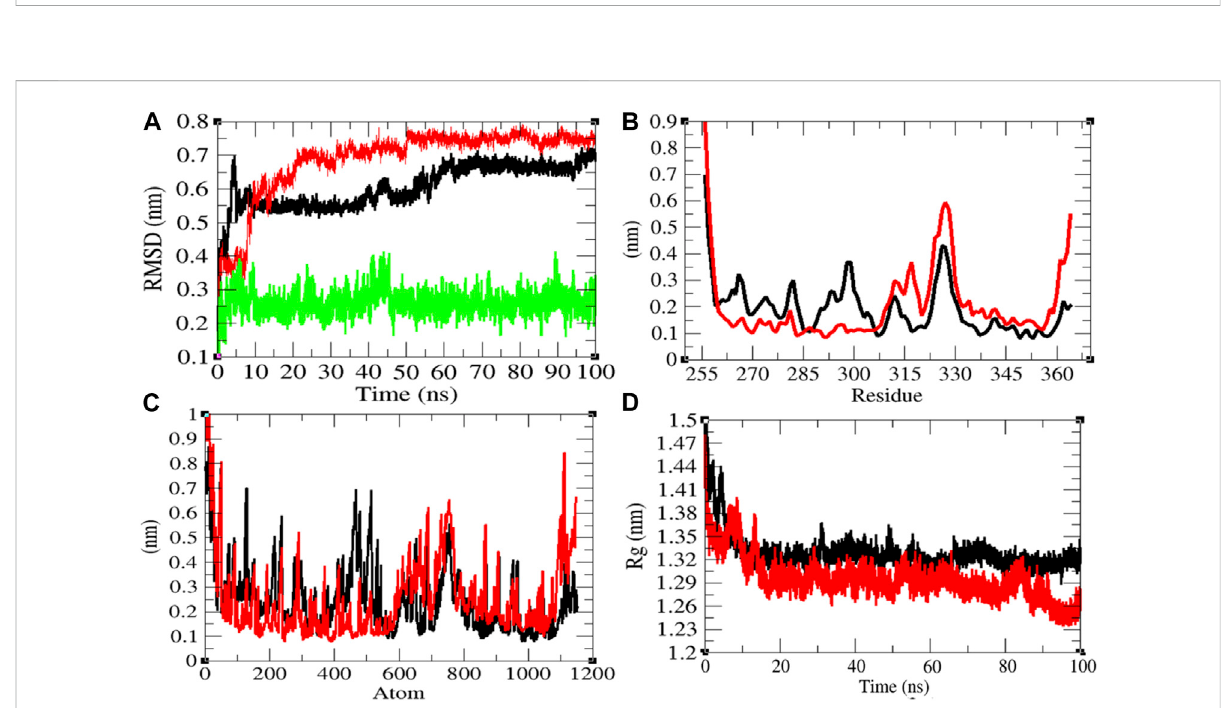
Structural dynamics ofCTD. (A) Root meansquare deviationsplotfor CTD(black), CTD-remdesivir(red),andremdesivir(green) asafunction of time. (B) Root mean square fl uctuations vs. residues. (C) Root mean square fl uctuations vs. atoms. (D) Radius of gyration ( R g )